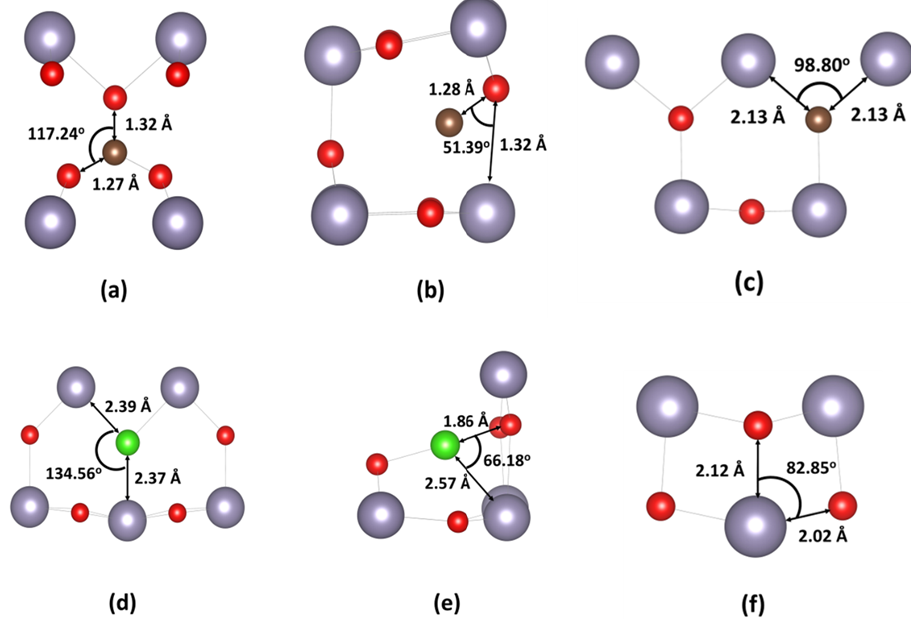
Figure 1. The doped cases examined: ( a ) C in Sn site, ( b ) C interstitial, ( c ) C as O substitutional ( d ) Cl interstitial, ( e ) Cl as O substitutional and ( f ) Sn interstitial.